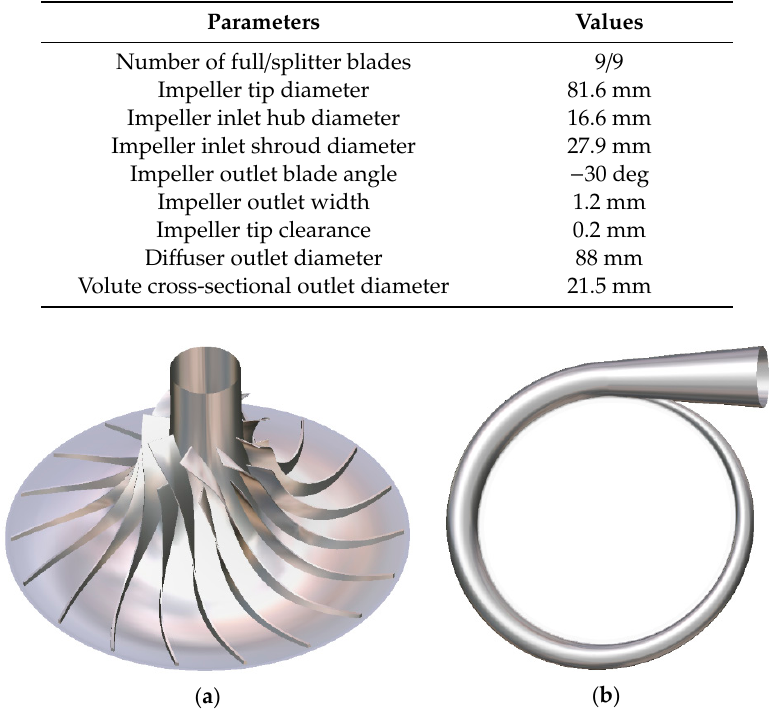
Figure 9. The solid model of the optimal compressor stage: ( a ) Impeller; and ( b ) Volute.